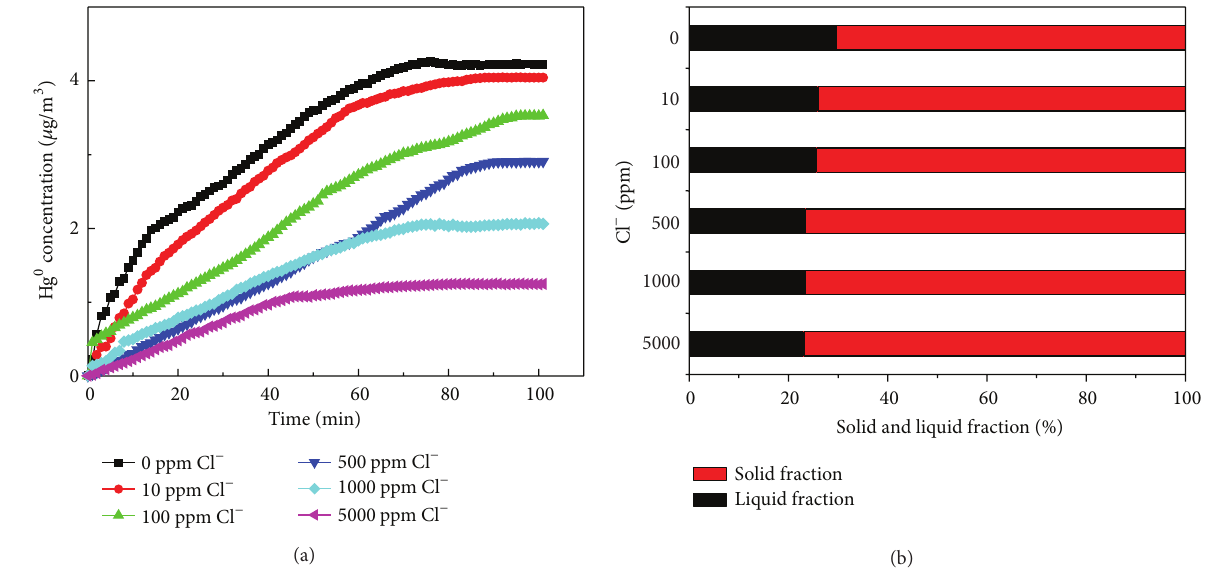
Figure 5: (a) Effect of the Cl − concentration on Hg 0 reemission. (b) Relationship between the proportion of mercury retained in the solid and liquid fraction of the slurry and the Cl −